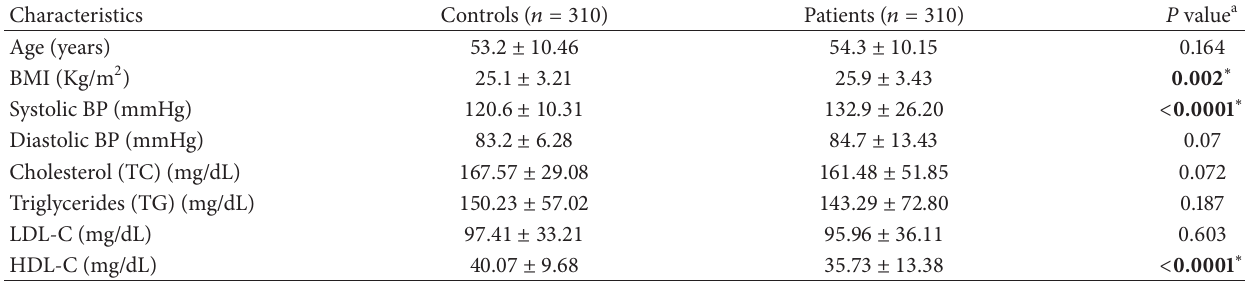
Table 1: Baseline and clinical characteristics of the study population.